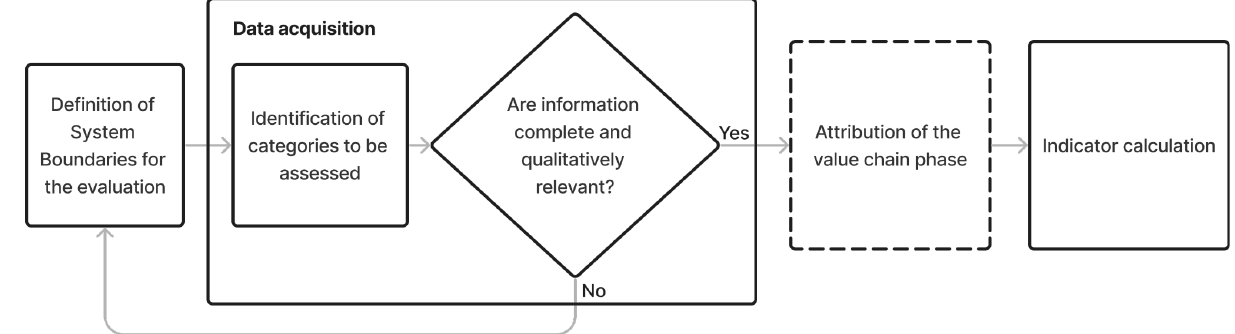
Figure 2. Flow diagram of the process of data